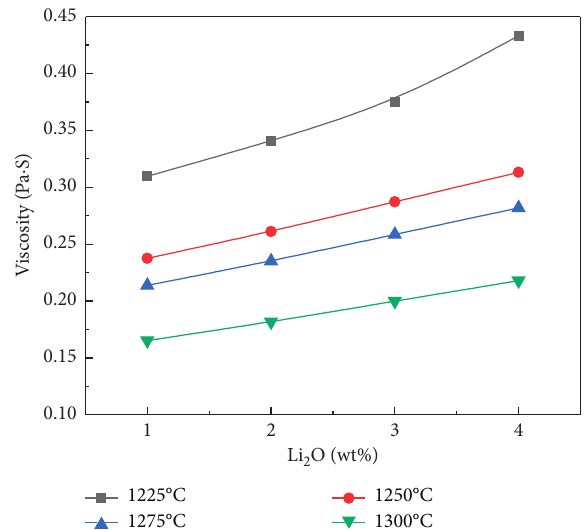
Figure 9: Viscosity of samples A1 to A4 in the fully fluid region with various Li 2 O contents.